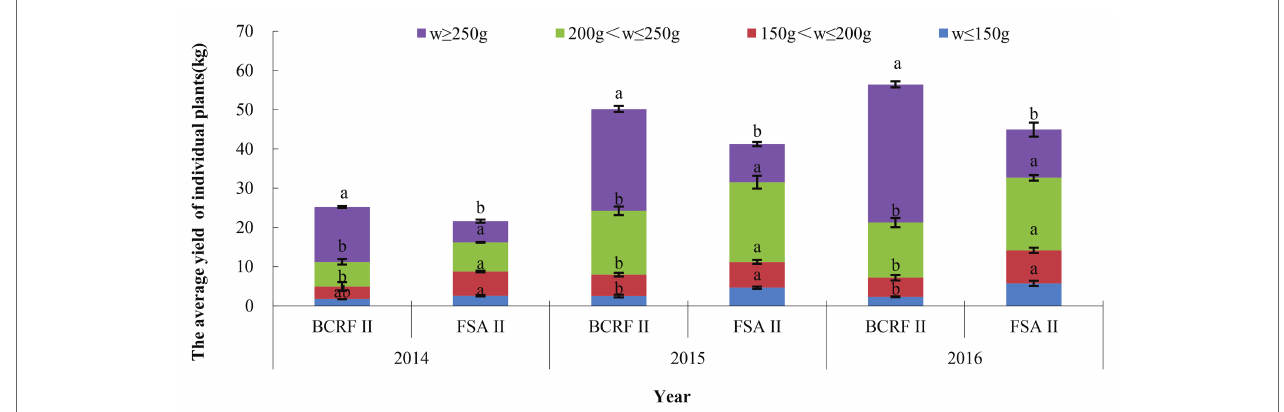
FIGURE 12 | The yield of individual plants under different fertilization modes. The vertical bars indicate the standard deviation of three replications. Different letters indicate statistically significant differences ( p < 0.05).